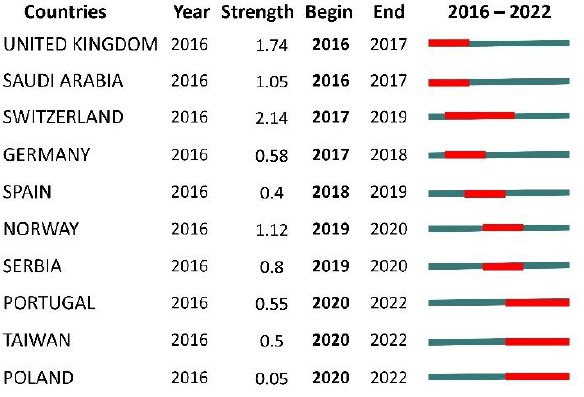
Figure 7. List of the relevant countries with citation bursts in the 1999 – 2019 time period.